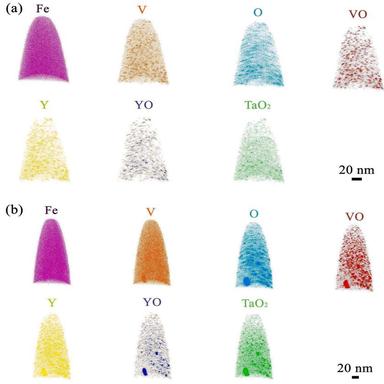
APT 3D reconstruction of (a) ODS Eurofer and (b) ODS Eurofer–2V–1.2Ta.